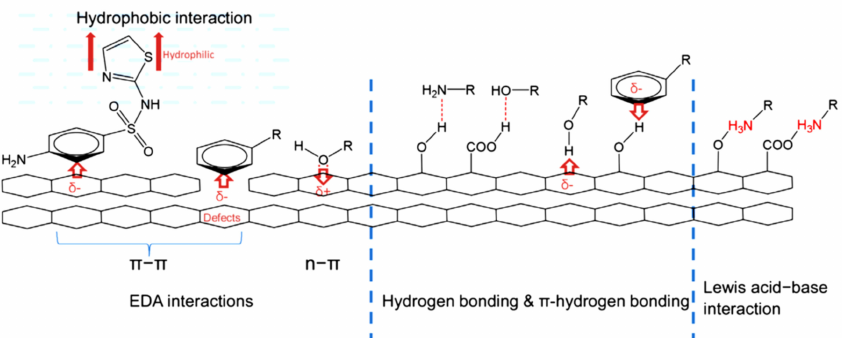
Figure 5. Mechanism of pharmaceutical adsorption by MWCNTs. Reprinted with permis- sion from